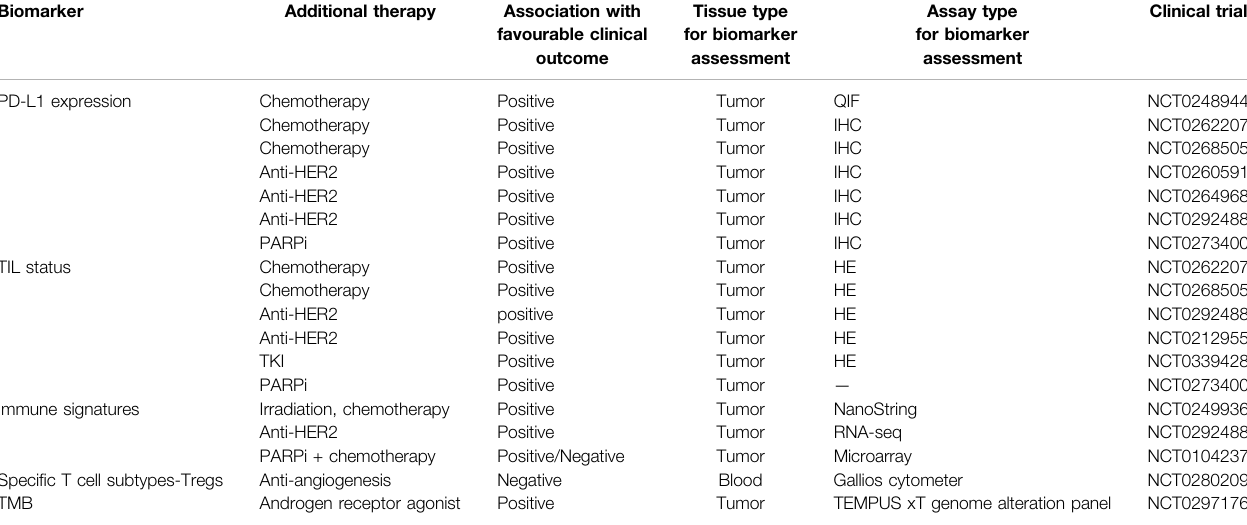
TABLE 3 | Predictive biomarkers for PD-1/PD-L1 blockade in combination with other cancer treatment regimens.